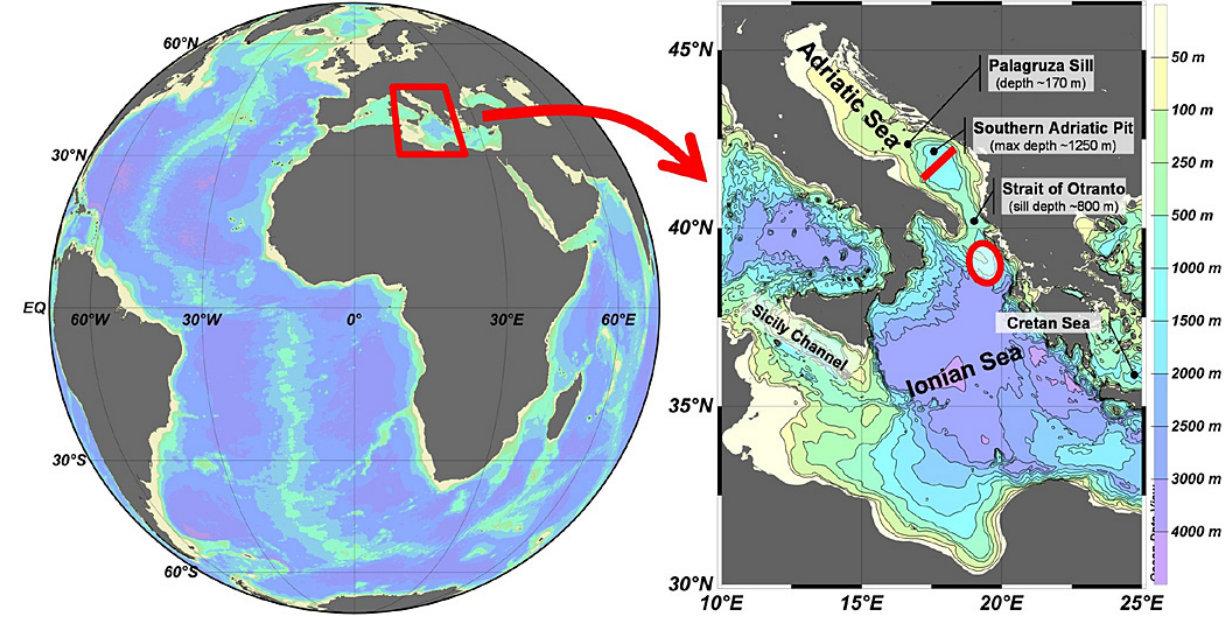
Fig. 1. Study area. Red line and red ellipse indicate the area from which the data used in the averaged time series were collected.